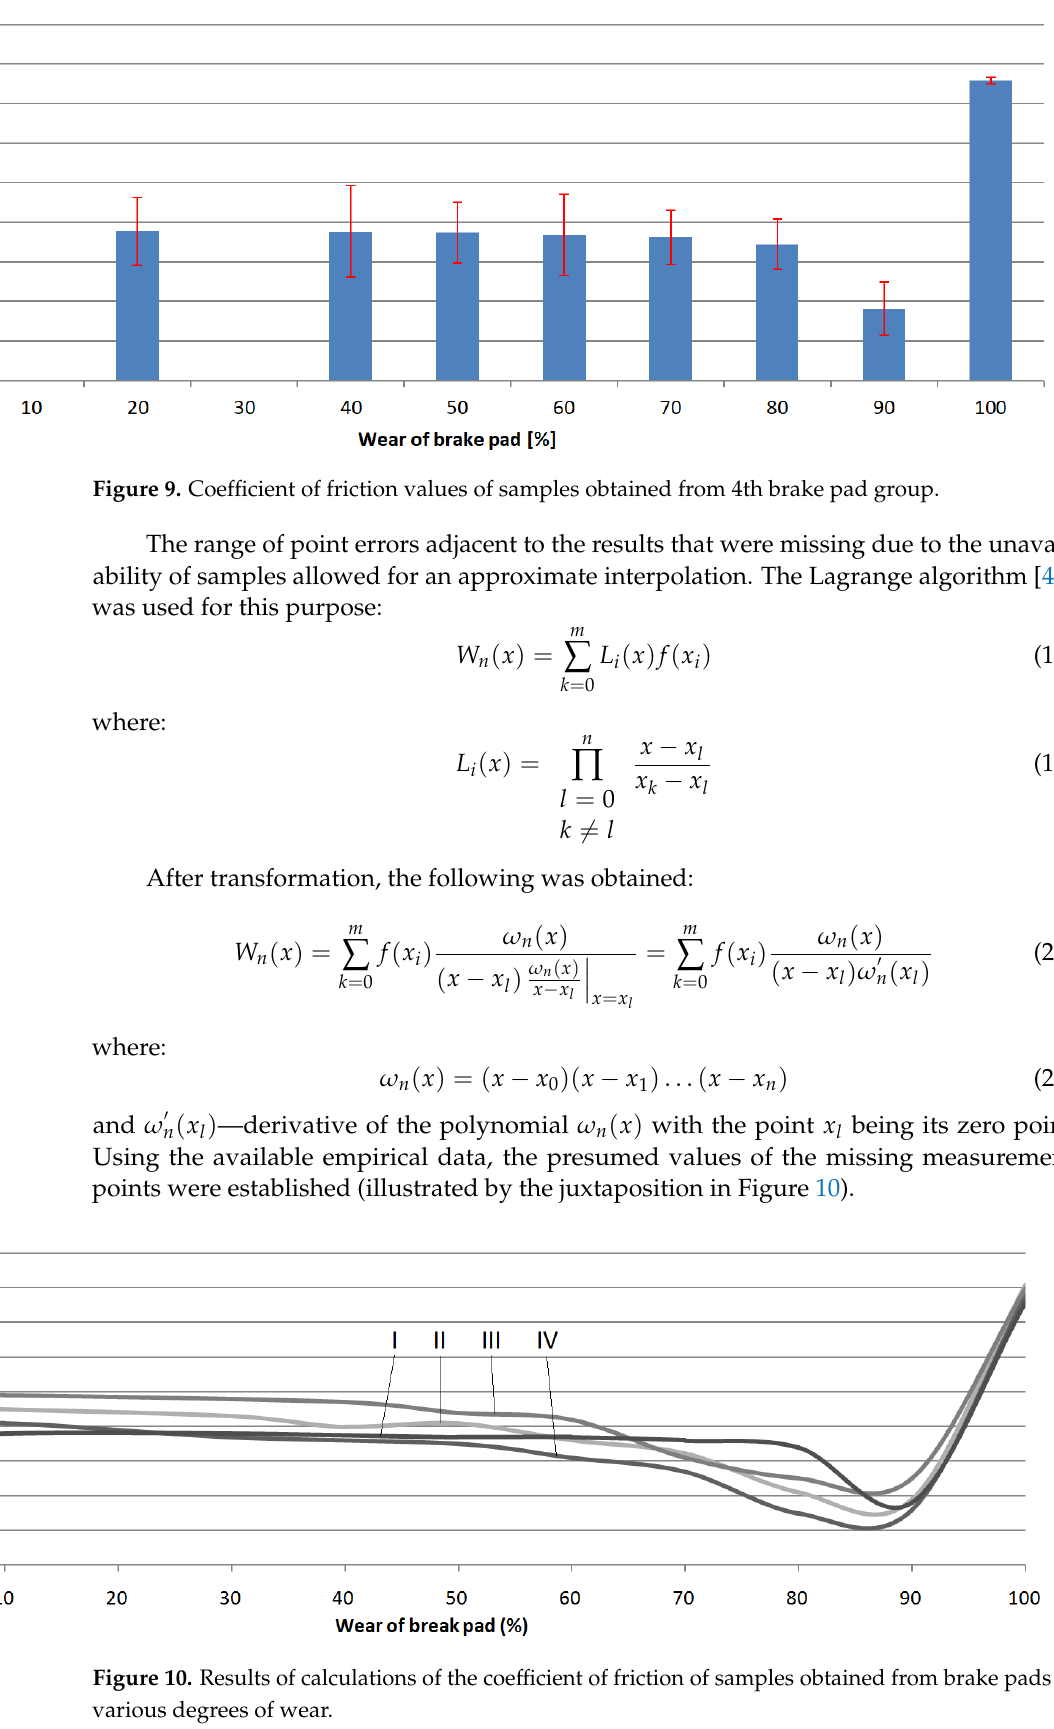
Figure 8. Coefficient of friction values of samples obtained from 3rd brake pad group.